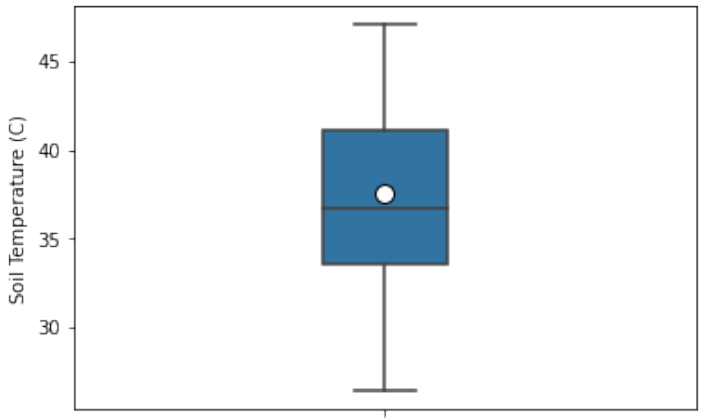
Figure 2. Box-plot of soil-moisture percentages, where the zero point of the box-plot represents the mean, the line intersecting the box shows the median value, and the lower and upper line of the whisker show the smallest and largest sample values.